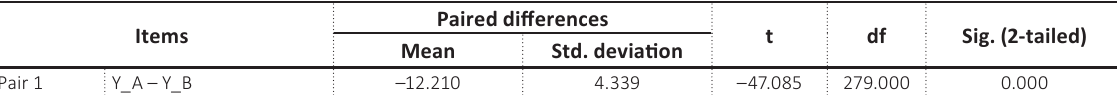
Table 4. Difference in income under the impact of Covid-19